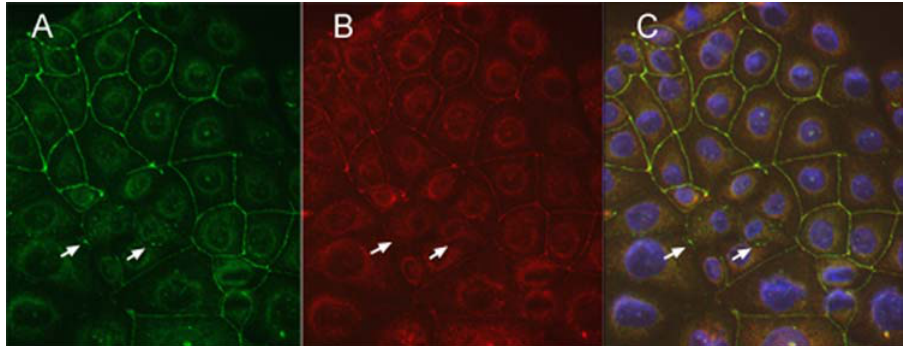
Figure 5. Distribution of transfected WT Bves in HCE cells. A stable cell line expressing WT Bves was grown to confluence and examined for Bves expression and distribution. Panel A demonstrates distribution of anti-Bves staining while B displays anti-Flag staining. Note that most staining overlaps (Panel C, merge) but small areas are observed that are positive for anti-Bves and negative for anti-Flag (arrows in A–C).